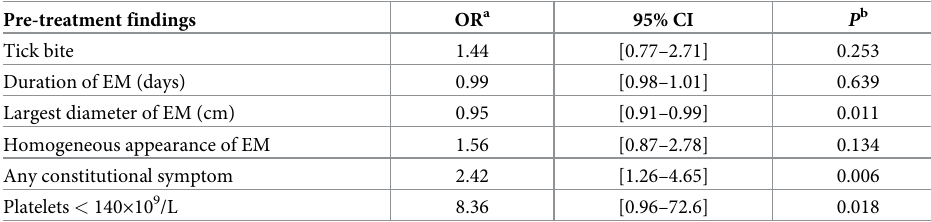
Table 3. Variables related to isolation of Borrelia afzelii from blood ( n = 116) or only from skin ( n =